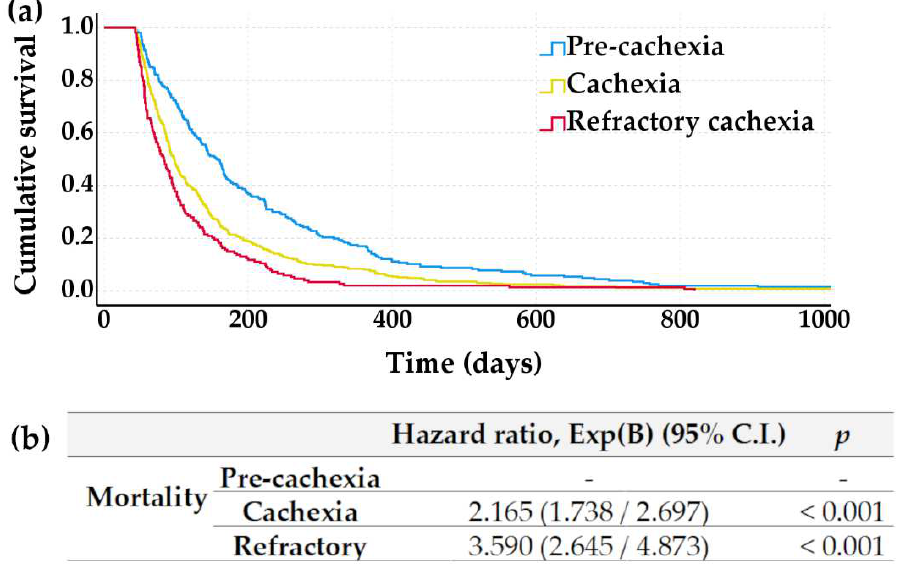
Figure 2. Survival according to cachexia stage at the entry in HAN for patients surviving more than 6 weeks. ( a ) Kaplan–Meier survival curves for patients in pre-cachexia, cachexia, and refractory cachexia; ( b ) Association between mortality and cachexia degree at the entry (KPS, BMI, cachexia) was analysed by a Cox regression adjusted for age, gender, KPS, and BMI at the entry. Patients with pre-cachexia are considered as a reference for the regression analysis.